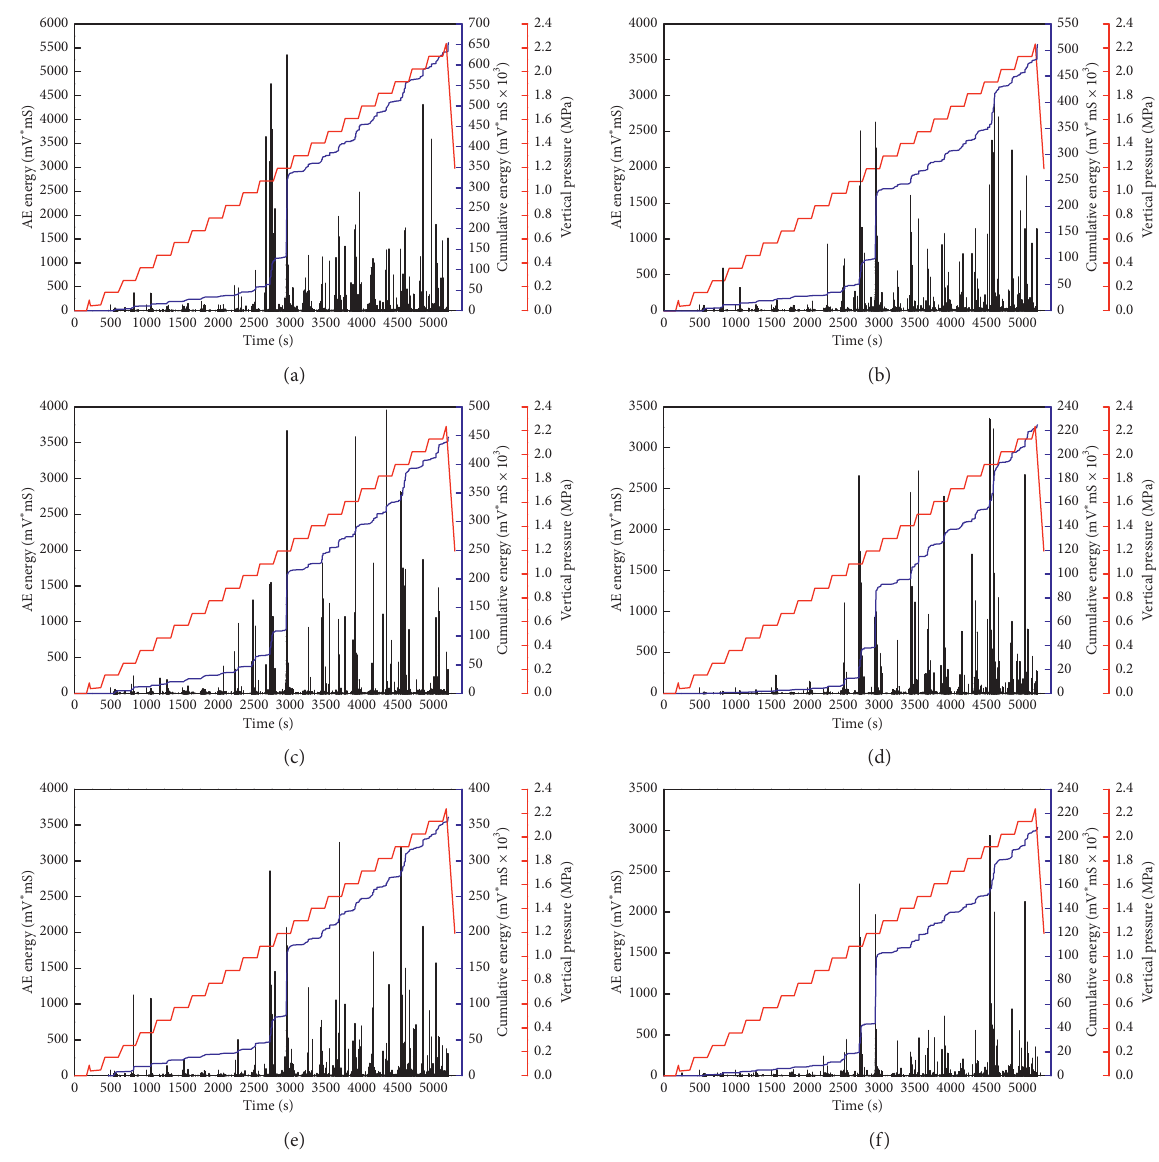
Figure 9: Variation of AE energy and load with time for AE sensors. (a) AE sensor 5. (b) AE sensor 6. (c) AE sensor 1. (d) AE sensor 2. (e) AE sensor 8. (f) AE sensor